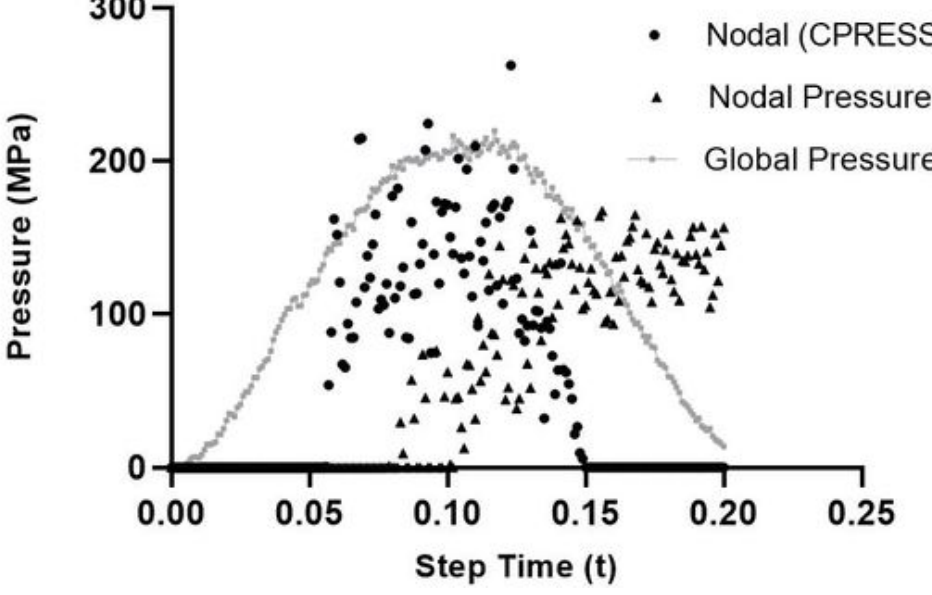
Figure 9. CPress, NPress and GPress